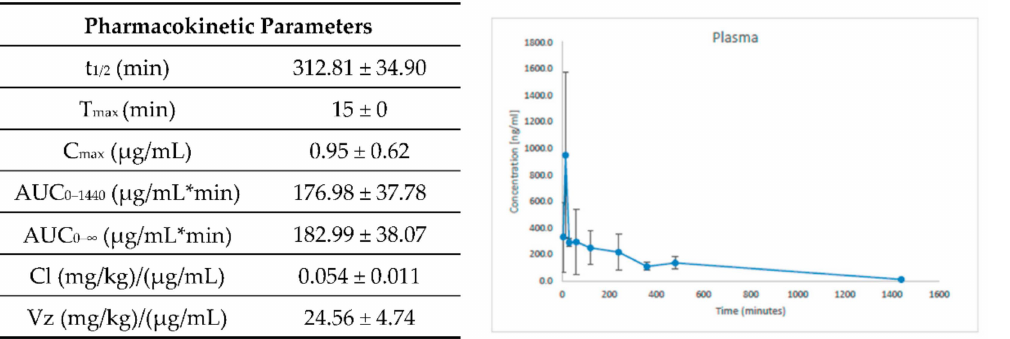
Figure 9. Plasma concentration of B06 at different times (5 min–24 h) after an intraperitoneal adminis- tration of 10 mg/kg. Basic PK parameters were calculated. C max : maximum observed concentration, T max : time of maximum observed concentration, t 1/2 : terminal elimination half-life, AUC 0–1440 : area under the curve from zero to the last sampling time, AUC 0– ∞ : area under the curve from zero extrapolated to infinity, Cl: plasma clearance, Vz: volume of